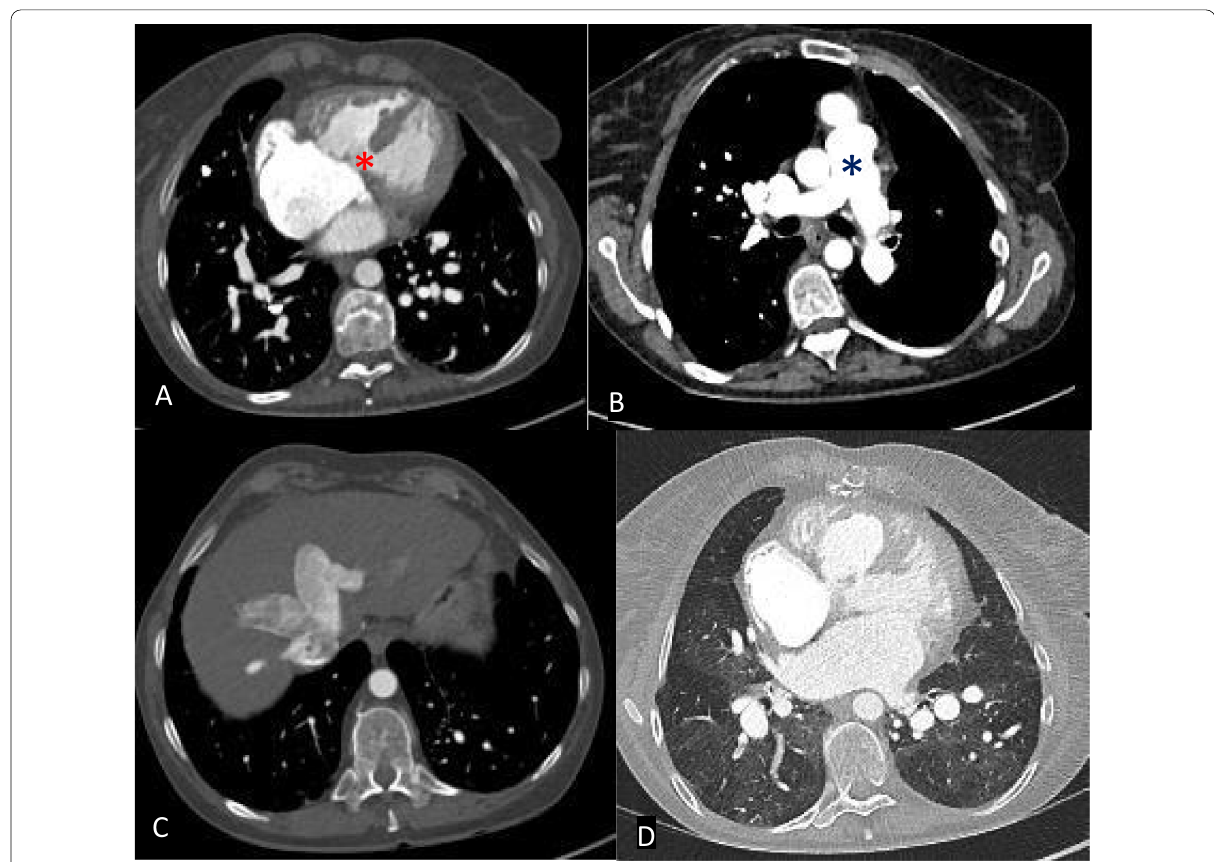
Fig. 14 Select axial CT images in the bone ( A and C ), soft tissue ( B ), and lung windows ( D ). A Large perimembranous VSD (red asterisk) and right ventricular hypertrophy. B Dilated pulmonary trunk (blue asterisk) C reflux of contrast into the IVC and hepatic veins D bilateral pulmonary parenchymal mosaicism. Findings are compatible with pulmonary hypertension and right ventricular heart strain due to a long-standing VSD. Although this is an example of an isolated VSD, similar features of pulmonary hypertension can be seen in large residual VSDs in the setting of repaired TOF or repaired D-TGA with a